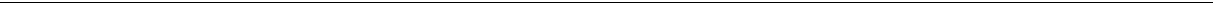
Figure 3 | Overexpression and underexpression of wild-type SF3B1 do not reproduce the splice pattern of SF3B1 hotspot mutations. ( a ) Effect of overexpression of wild-type and mutated SF3B1 on the AG’/AG ratio of DPH5 and ARMC9 in SF3B1 WT and SF3B1 MUT cell lines. MP41, Mel202, HEK293Tand SF3B1 K666T -HEK293Tcell lines were transiently transfected with expression vectors for SF3B1 WT and SF3B1 K700E . The protein overexpression was confirmed by immunoblotting with anti-Flag using b -actin as a loading control (upper panel). Ratios of expression levels of alternative AG’ and canonical AG forms (AG’/AG) of DPH5 and ARMC9 were determined by quantitative RT–PCR (lower panel). The results are average of three replicates and are represented as mean ± s.d. Paired t -test was used to generate the P -values comparing each condition to the empty vector transfection: NS, non-significant; * P 4 0.05; *** P o 0.001. ( b ) Effect of siRNA-mediated knockdown of SF3B1 on the AG’/AG ratio in cell lines. HEK293T, MP41 and Mel202 cells were transiently transfected with non-target control siRNA or two different si SF3B1 : ‘4’and ‘5’. Proteins and RNA were extracted at 48h after transfection. siRNA-mediated knockdown was confirmed by immunoblotting with anti-SF3B1, using anti- b -actin as a loading control. Numbers represent the protein band intensity normalized to b -actin and expressed as a percentage of control samples (upper panel). Ratios of expression levels of alternative AG’ form to the expression level of canonical AG form (AG’/AG) of DPH5 were determined by quantitative RT–PCR (lower panel). The results are average of three replicates and are represented as mean ±